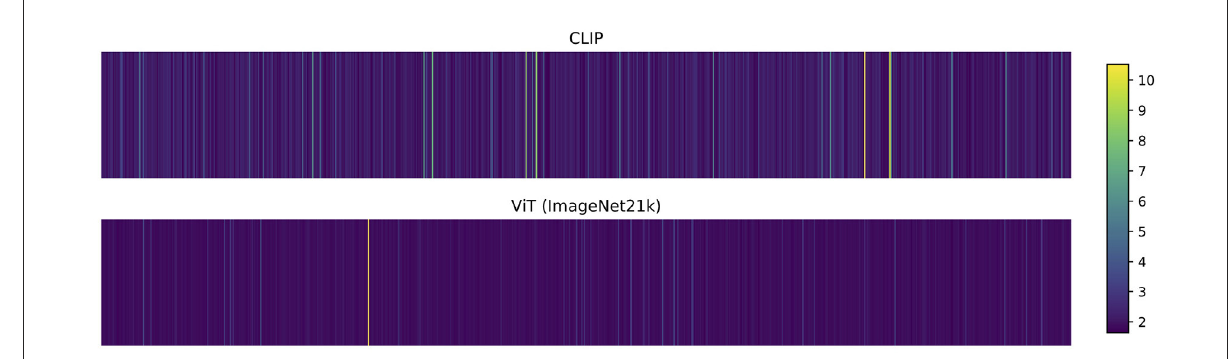
FIGURE3 Visualized weights of the linear regression trained on AVA. While the ImageNet-pretrained Vision Transformer (ViT) uses mainly one feature in the estimation of the target score, CLIP’s features are more broadly used. Together with the fact that the linear regression on CLIP features outperforms ImageNet features, this indicates that CLIP’s image features encode more useful and broader information for the IAA